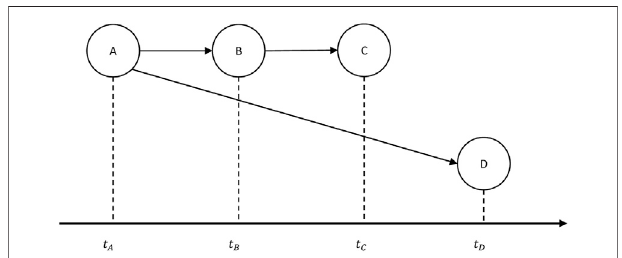
FIGURE 4 | An illustrative example of structural context in